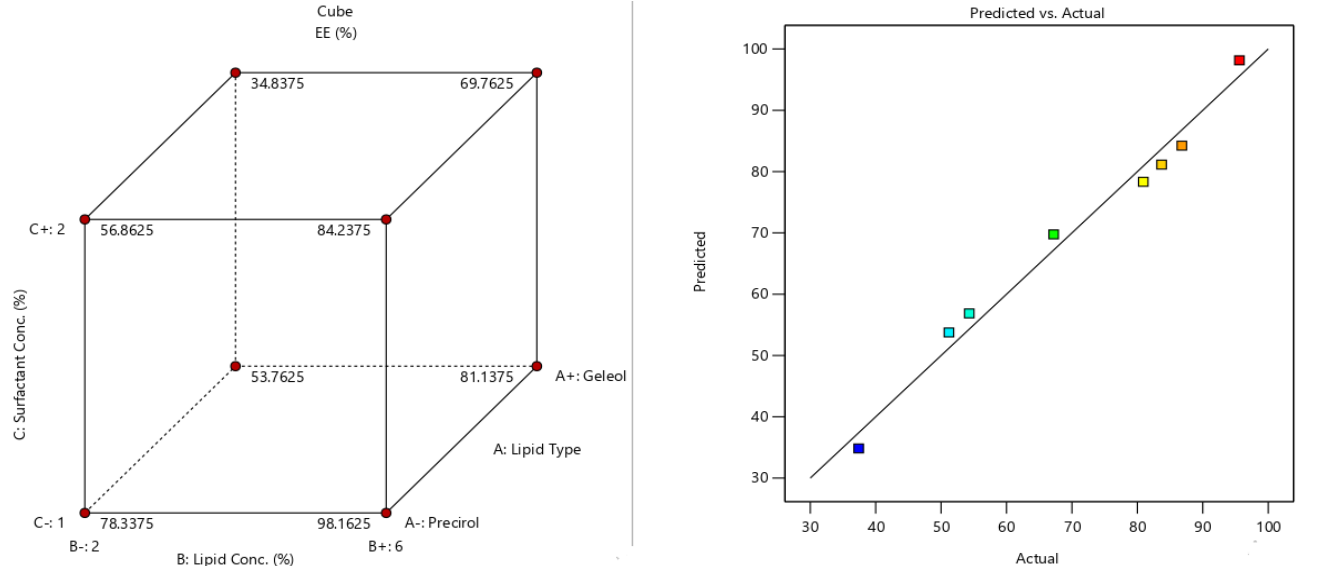
Figure 11. The impact of A: Lipid type, B: Lipid conc., C: surfactant conc. On EE percent of 4h-loaded NLC is represented in cubic plot and predicted versus actual values plot.